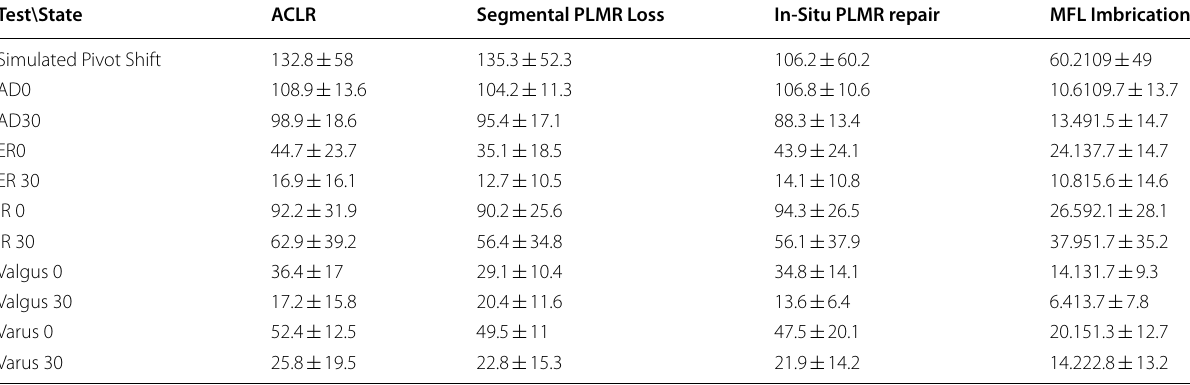
Table 1 Mean ACL Graft force (N) by State (columns) and Test (rows)